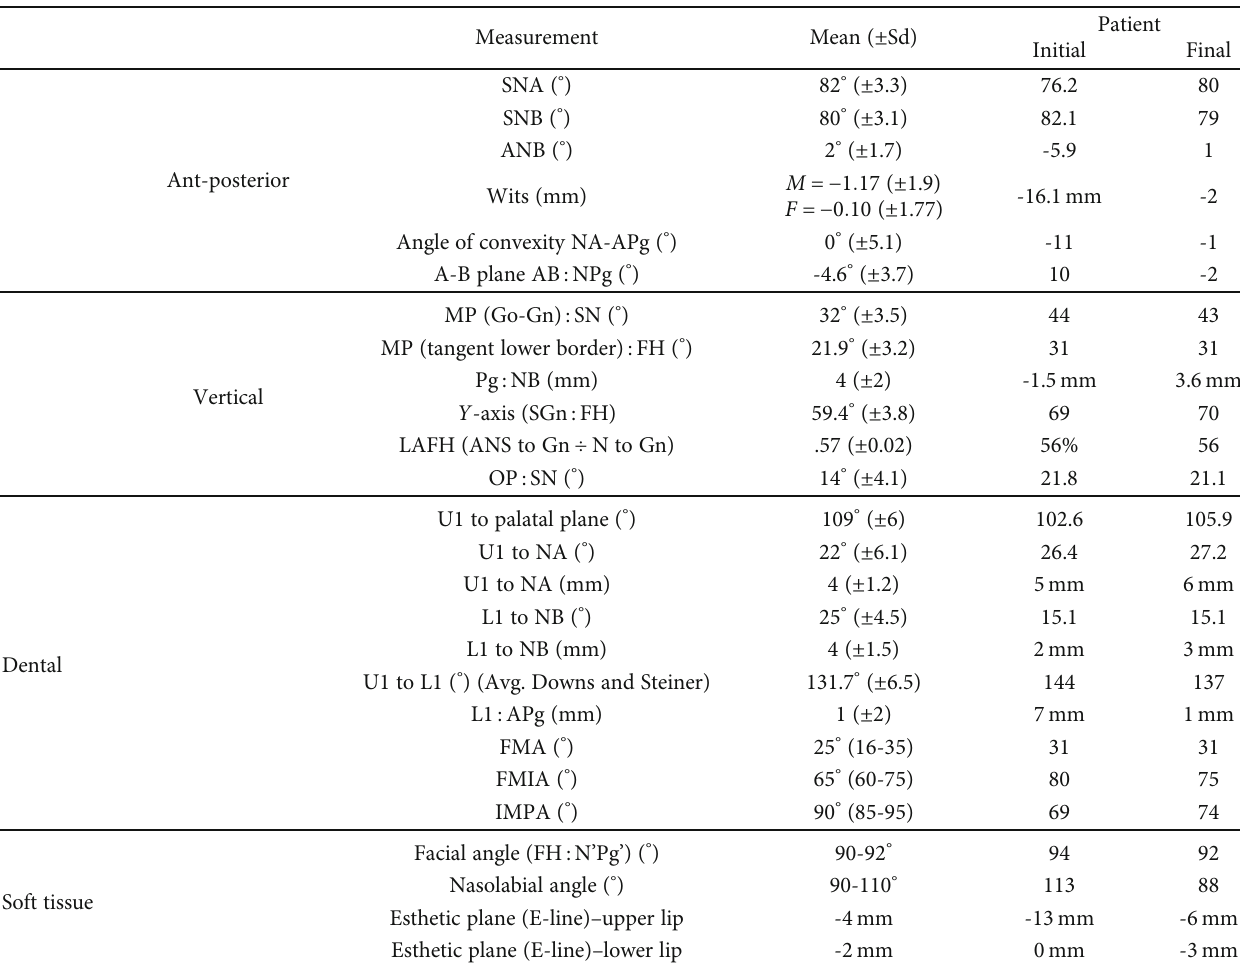
Table 1: Cephalometric